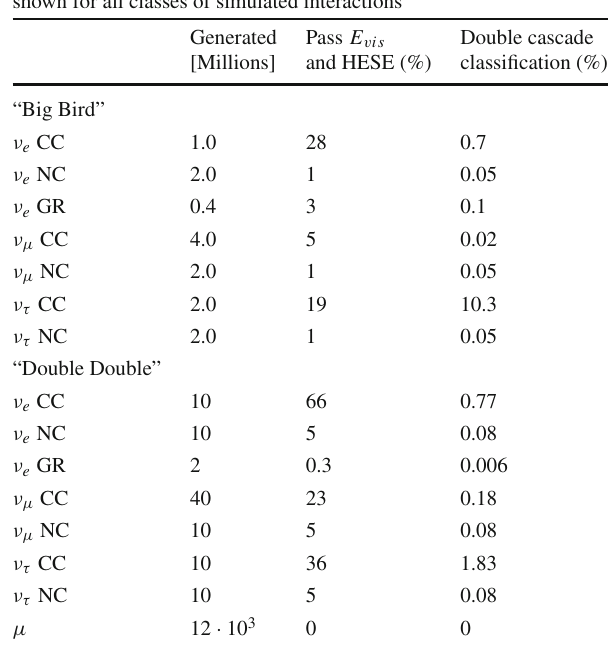
Fig. 7 Comparison of the flavor composition measurement using the HESE likelihood with ternary topology identification and 2D MC dis- tributions for each topology (blue) with the measurement using the extended likelihood for double cascades as shown in Fig. 6